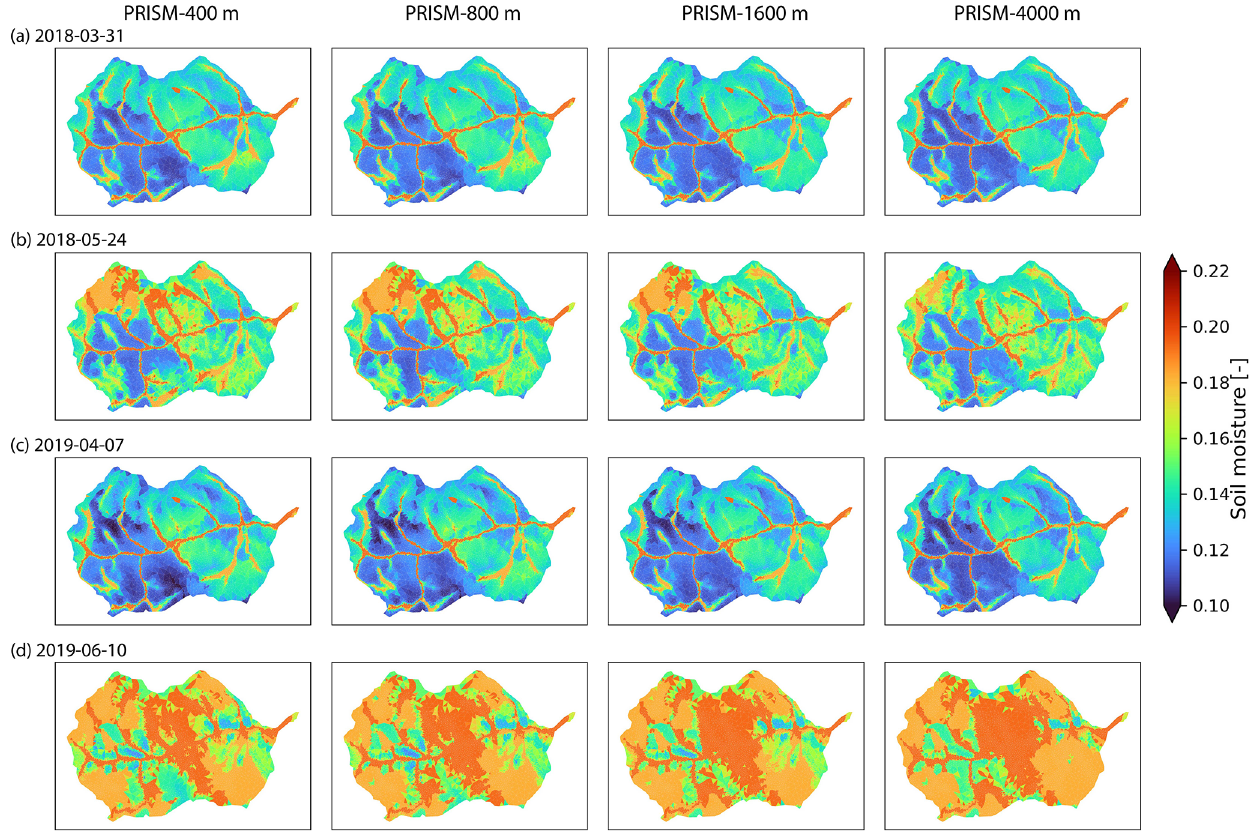
Figure A11. Spatial distribution of soil moisture at land surface under different spatial resolutions of PRISM at four different times.